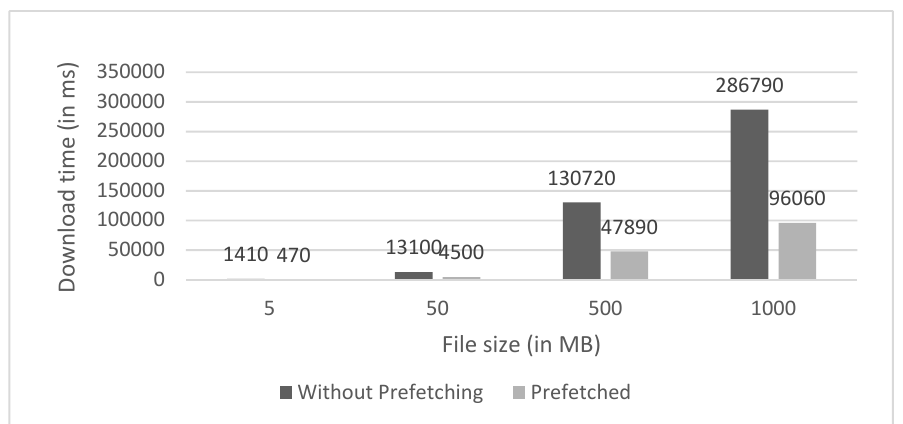
Figure 9. Average download times (in ms) of health record resources with various sizes (5 MB, 50 MB, 500 MB, and 1 GB) when the storage cloud and the prefetch engine were deployed in infrastructures with different physical locations.